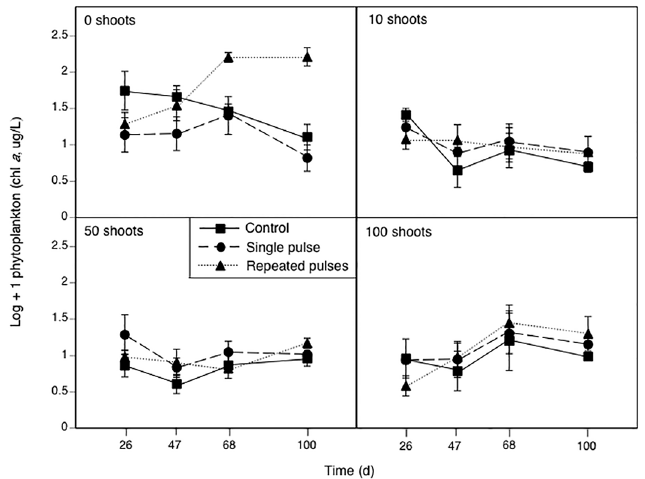
Fig 4. The effects of different malathion exposure scenarios in the presence of four Elodea treatments planted with different initial numbers of plant shoots on phytoplankton abundance (measured as chlorophyll a ) over time. Data are means ± 1